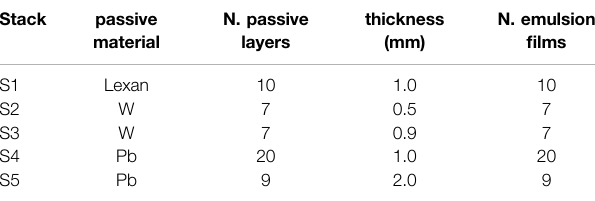
TABLE 2 | ES Section 3 composition in the GSI 2019 data